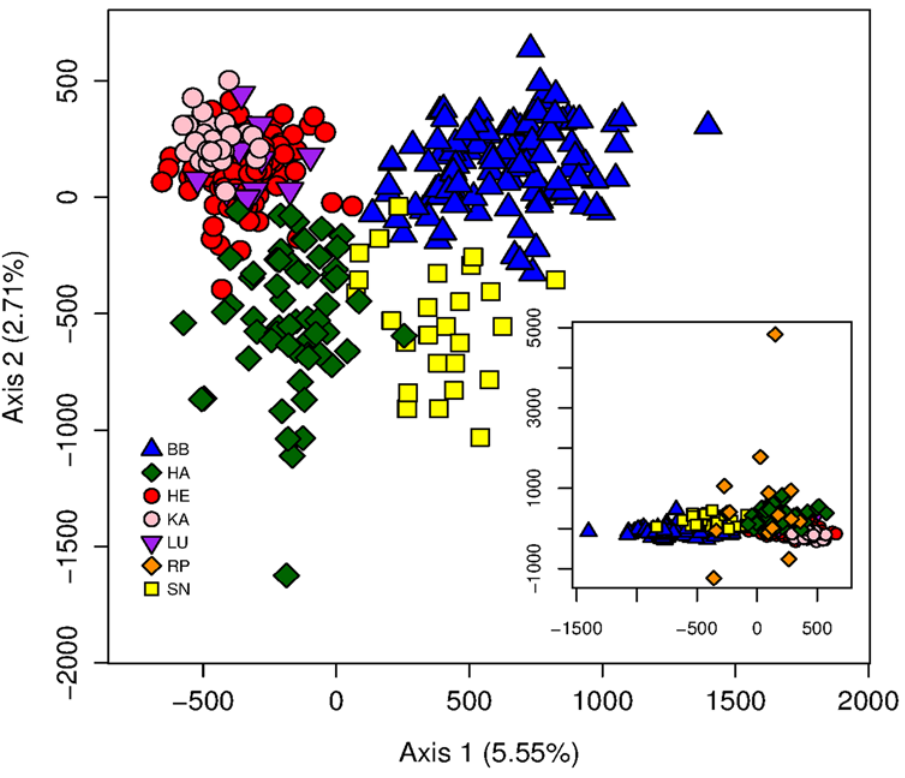
Fig 3. Factorial correspondence analysis of 393 raccoons assigned to the six main STRUCTURE clusters. Symbols and colors represent the different genetic clusters according to the STRUCTURE analysis. Inset: Factorial correspondence analysis with the seventh STRUCTURE cluster (RP) that mostly contained recently introduced individuals.